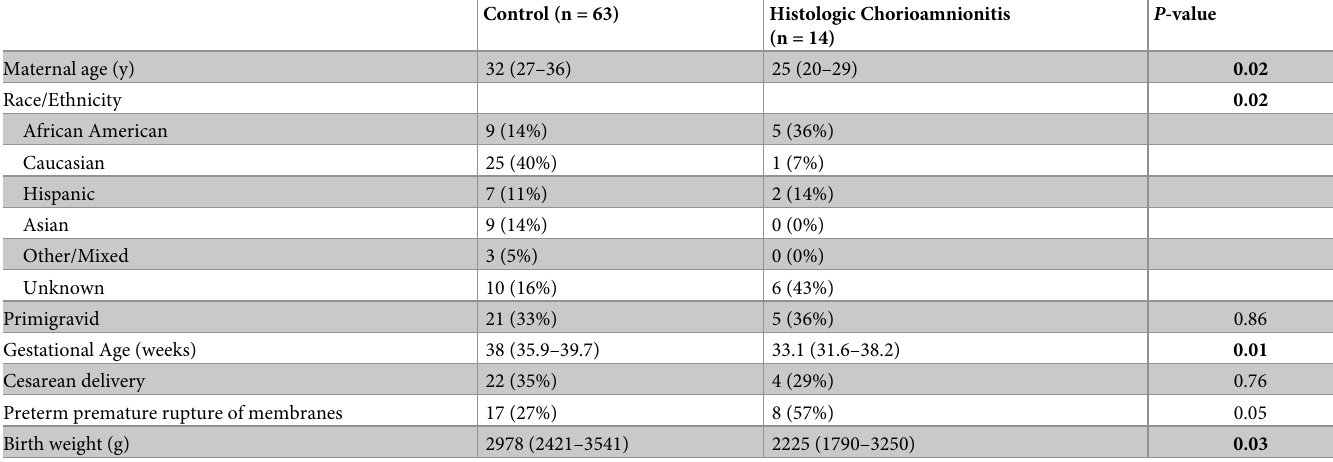
Table 1. Demographics data of paired maternal plasma and umbilical cord plasma samples with valid NGS results (n =